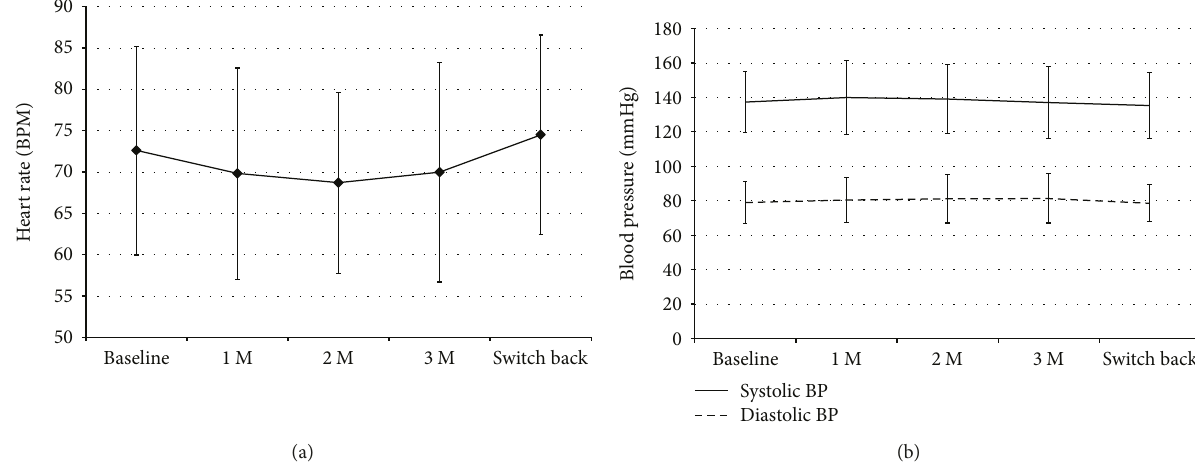
Figure 4: Changes in systemic circulatory parameters during the study period. (a) Heart rate. (b) Systolic and diastolic blood pressure. M: months; BPM: beats per minute; BP: blood pressure.